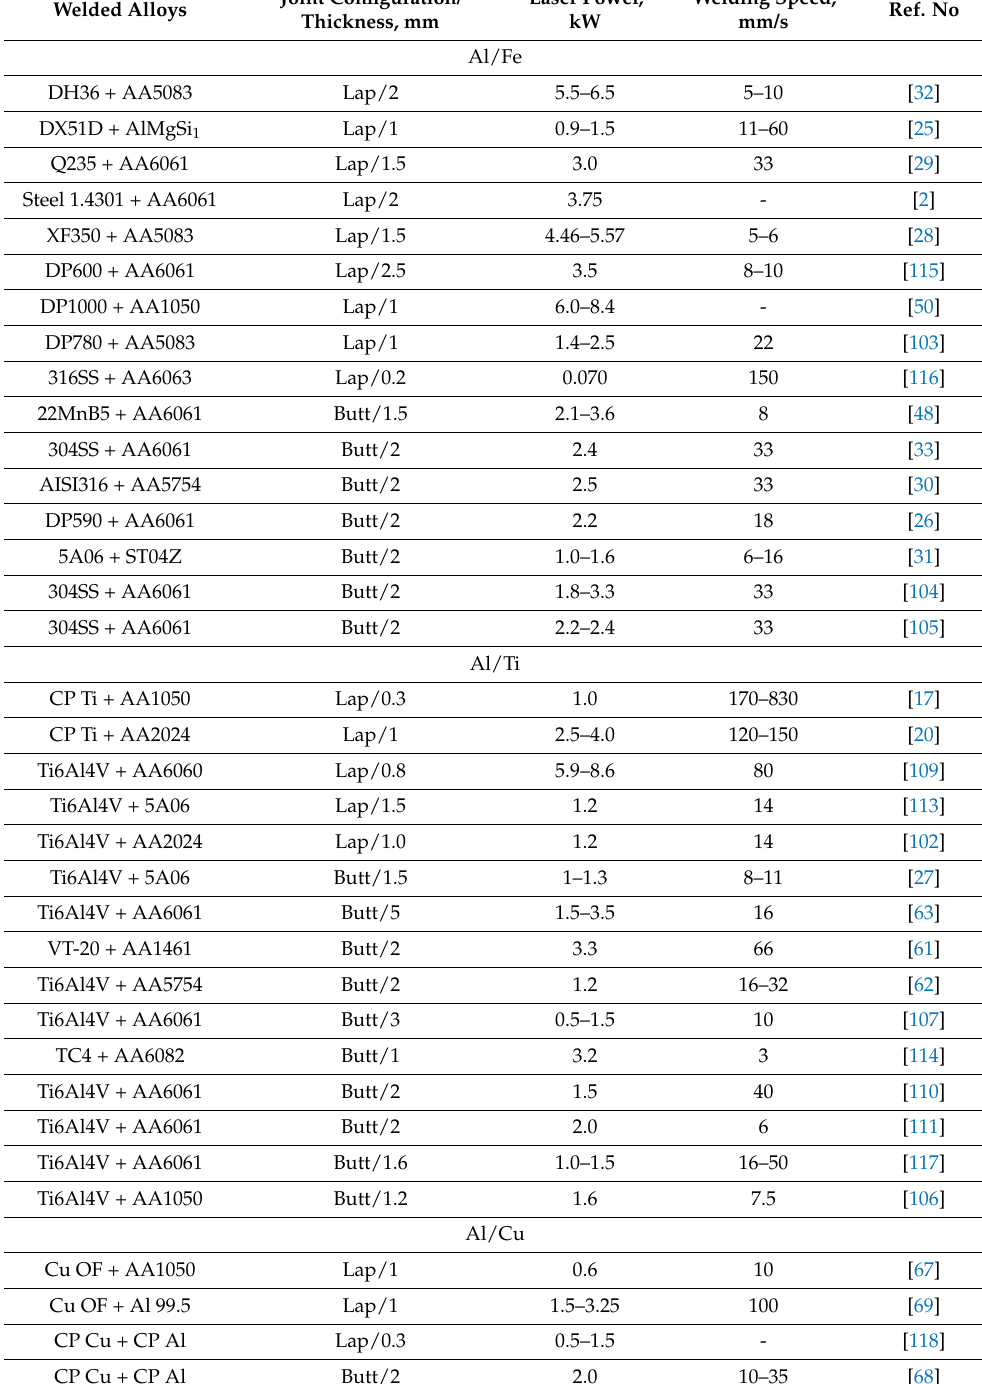
Table 5. Value of the laser power and welding speed. Author’s own